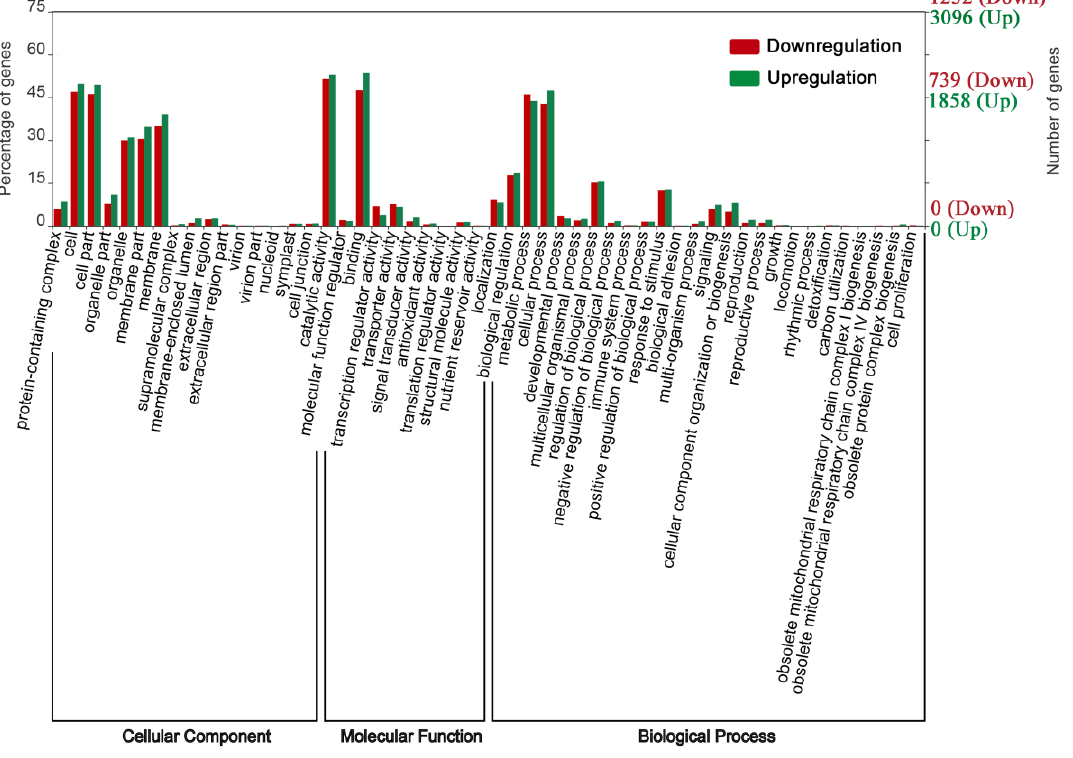
Figure 4. Gene Ontology classification of upregulated and downregulated differential genes. The X axis represents different GO terms. The left Y axis represents the percentage of genes and the right Y axis represents the number of genes. The upper number in the right Y-axis refers to Down-regulation, and the number below represents Up-regulation. Red columns refer to down-regulated genes, green columns refer to up-regulated genes.